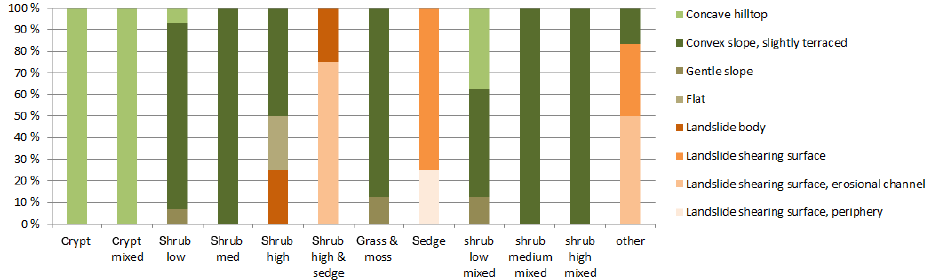
Figure 8. Comparison of topographic units (source CALM metadata, Earth Cryosphere Institute, Siberian Branch of the Academy of Sciences (SB RAS)) and vegetation type (survey of August 2015) at the CALM grid, illustrating the interrelation of certain topographic features and specific vegetation